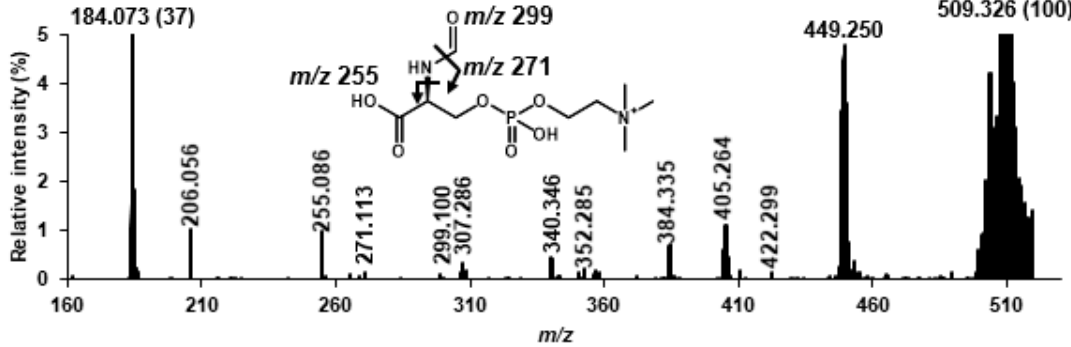
Figure 4. HAD–MS/MS spectrum of Lyso-SM-509. HAD, hydrogen abstraction dissociation; MS/MS, Figure 4. HAD–MS / MS spectrum of Lyso-SM-509. HAD, hydrogen abstraction dissociation; MS / MS, tandem mass spectrometry. tandem mass